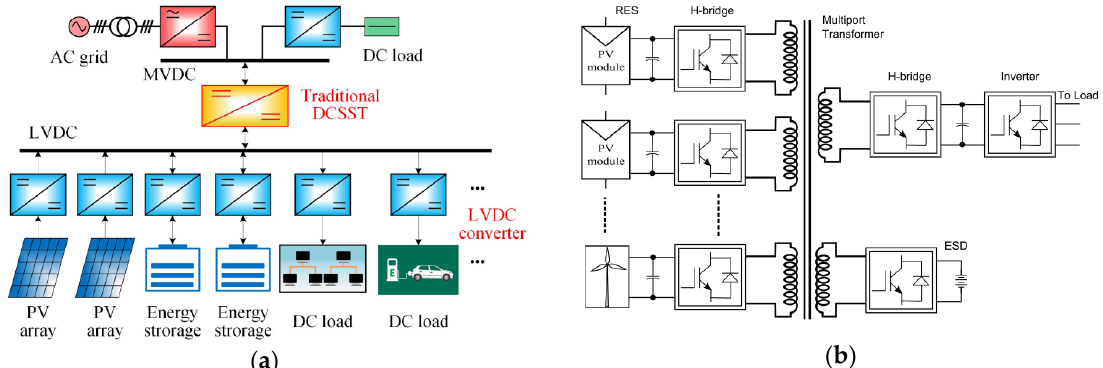
Figure 2. Possible topologies for multi-port smart transformer: ( a ) [18], ( b ) [19].